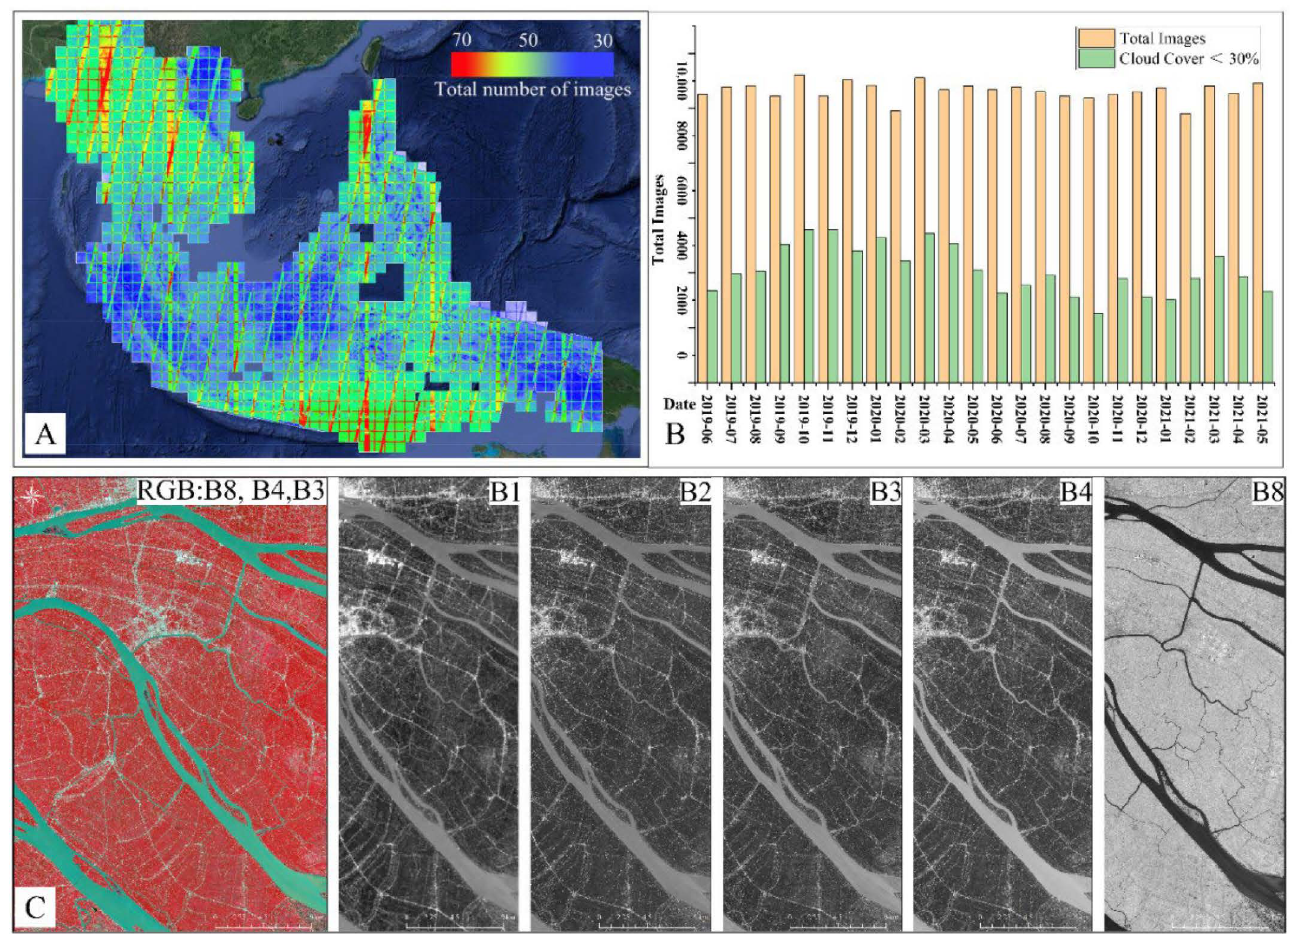
Figure 2. Geographic, temporal, and spectral coverage of the Sentinel-2 Level-2 surface reflection archive between 1 June 2019 and 31 May 2021 in Southeast Asia: ( A ) Total image number of a single pixel. ( B ) The number of images per month. ( C ) Spectral display of B1, B2, B3, B4, and